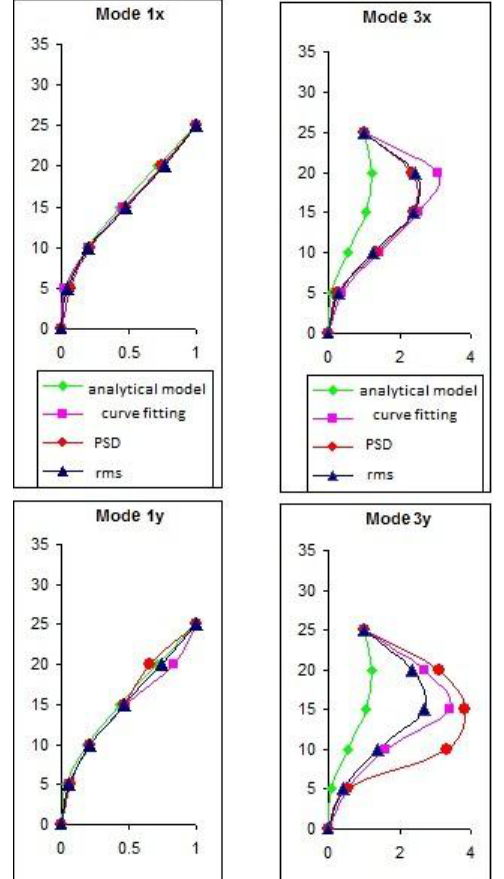
Fig. 7. Comparison among various methods used to determine the 1st and 2nd modes of translation (1 and 3) for the x and y